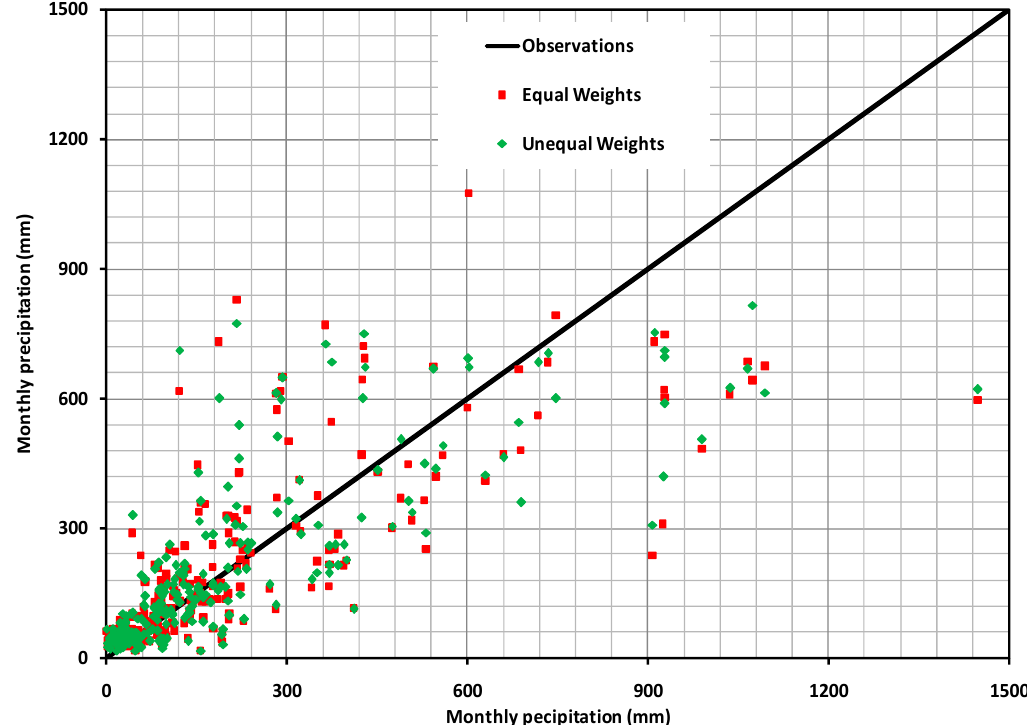
Figure 3. Scatter plot ofthe precipitation simulations with equal and unequal weights minus observations over the whole VG-TB during 1989–2008 (mm/month).